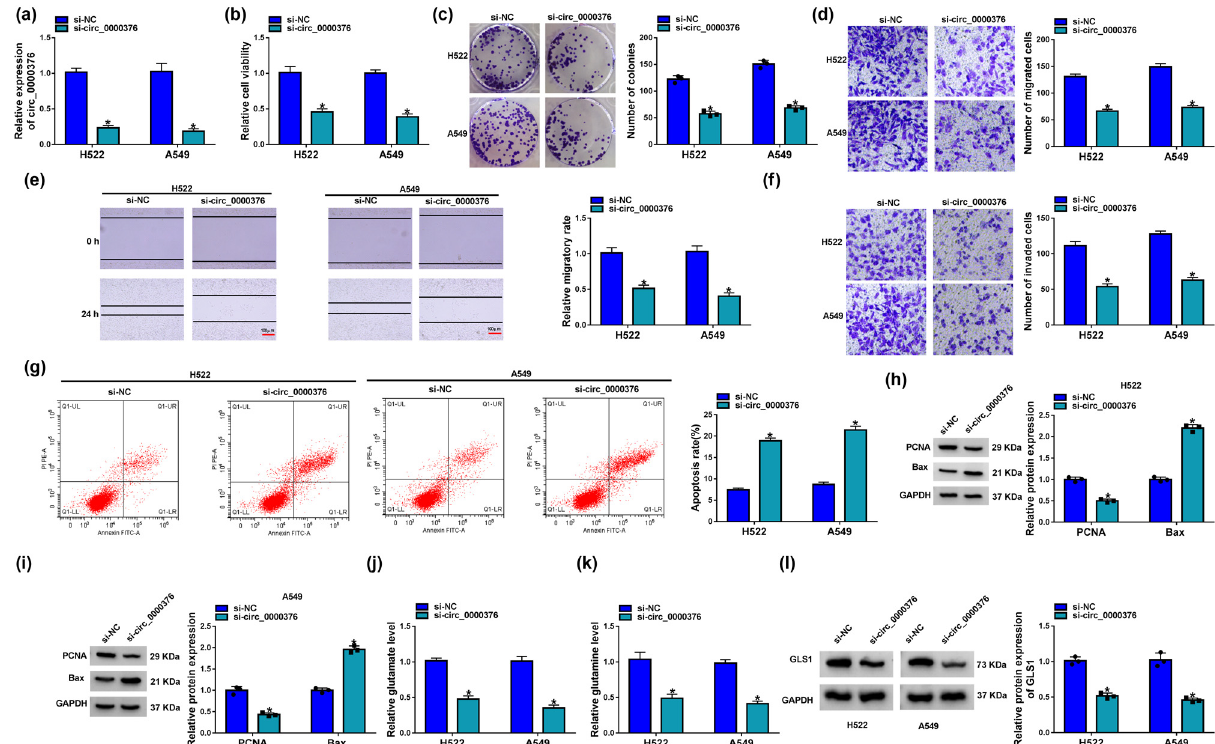
Figure 2: circ_0000376 absence repressed NSCLC cell tumor properties. ( a – l ) Both H522 and A549 cells were transfected with si - NC and si - circ_0000376, respectively. ( a ) Interfering e ffi ciency of si - circ_0000376 was determined by qRT - PCR. ( b and c ) Cell viability and colony - forming ability were detected by CCK - 8 and colony formation assays, respectively. ( d and e ) Transwell migration and wound - healing assays were performed to analyze the migratory ability of H522 and A549 cells. ( f ) Transwell invasion assay was carried out to determine the invasive ability of H522 and A549 cells. ( g ) Cell apoptosis was detected by fl ow cytometry analysis. ( h, i, and l ) PCNA, Bax, and GLS1 protein expression were detected by western blot analysis. ( j and k ) Levels of glutamate and glutamine were determined by glutamate detection and glutamine determination assays, respectively. * P <